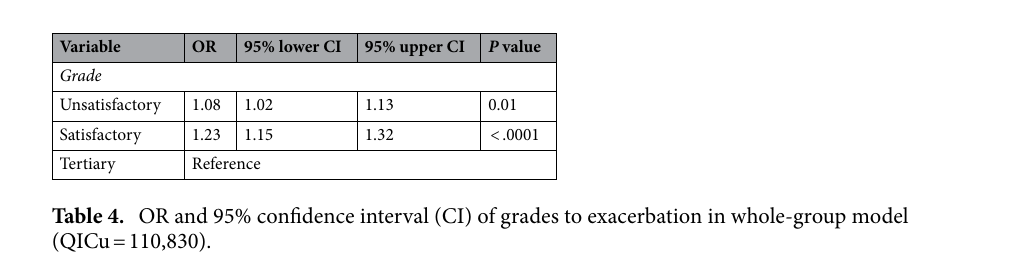
Figure 3. Severity distribution according to the assessment grade of visited medical institutions. Mosaic plot showing the distribution of assessment grade and severity.